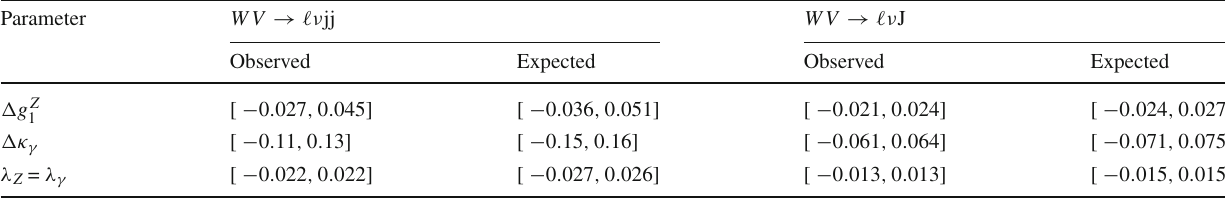
Table 6 The observed and expected 95% confidence intervals for the aTGC parameters in the LEP-constraint scenario with (cid:17) FF = ∞ , com- puted separately for the WV → (cid:4)ν jj and WV → (cid:4)ν J channels. The